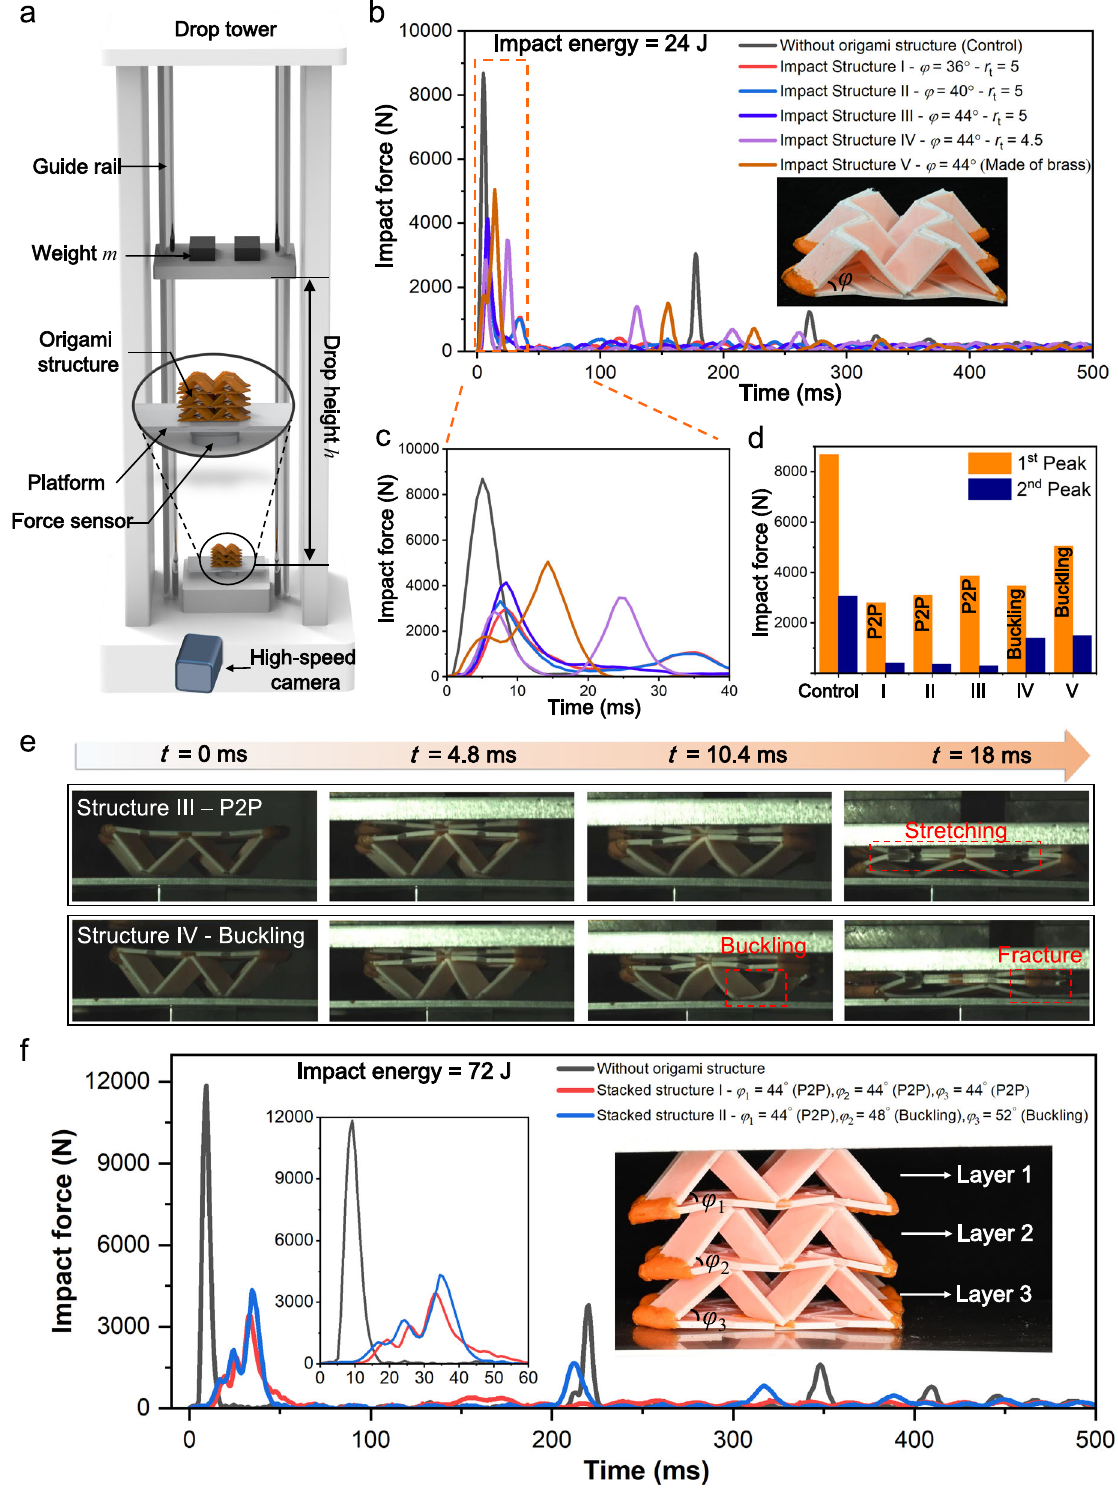
Fig.5| Impactabsorptionof3Dprintedself-lockingthick-panelorigami-based mechanicalmetamaterials.a Illustrationofaself-builtdroptowerforimpacttest. b Impact response ofstructures under impactenergy of 24J. c Impactresponse of structures under impact energy of 24J within the fi rst 40ms. d 1 st and 2 nd peak